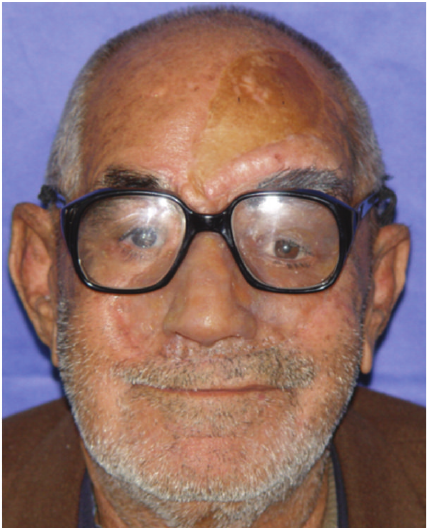
Figure 7: Completed facial prosthesis in